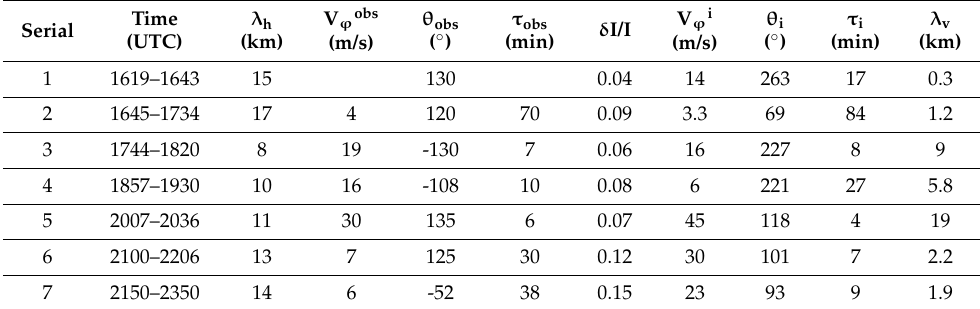
Figure 23. ( a ) Power spectral density (PSD) of the N/S (blue) and W/E (red) keograms for the night of 9 October. The black dashed line shows the −5/3 power law; ( b ) Periodogram for the N/S keogram for the shortest wavenumbers. T represents the period, the ordinate the horizontal wavenumber; ( c ) Same as ( a ) but before (blue) and after (red) 1910 UTC. Table 3. Same as Table 2 but for 10 October